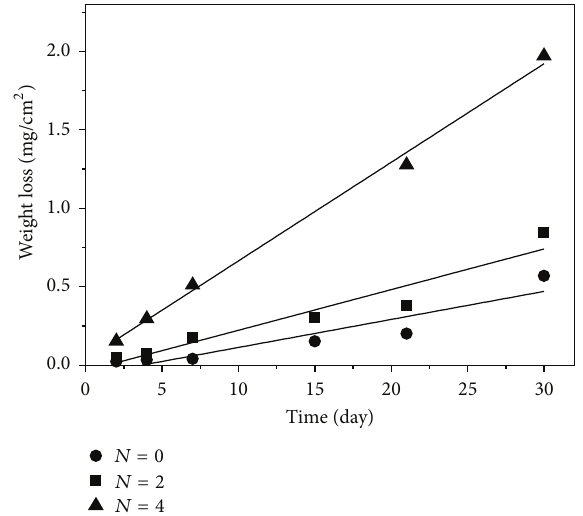
Figure 9: Corrosion rate variation with the immersion time of the nondeformed ( 𝑁 = 0 ) and ECAP’ed ( 𝑁 = 2 and 4), at 25 ∘ C in 3.5 wt.% NaCl solution at pH =